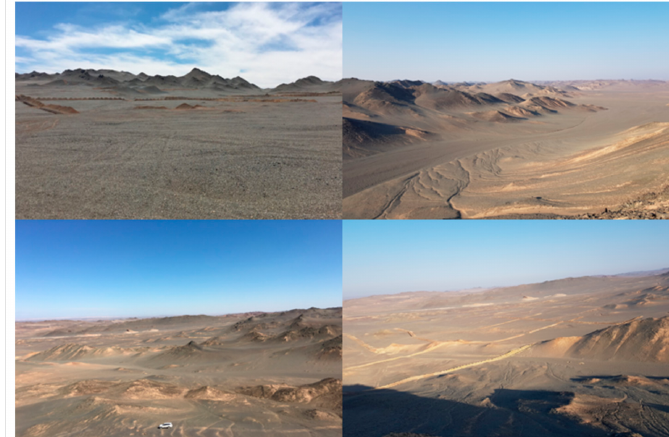
Figure 2. Local topography of the study area.